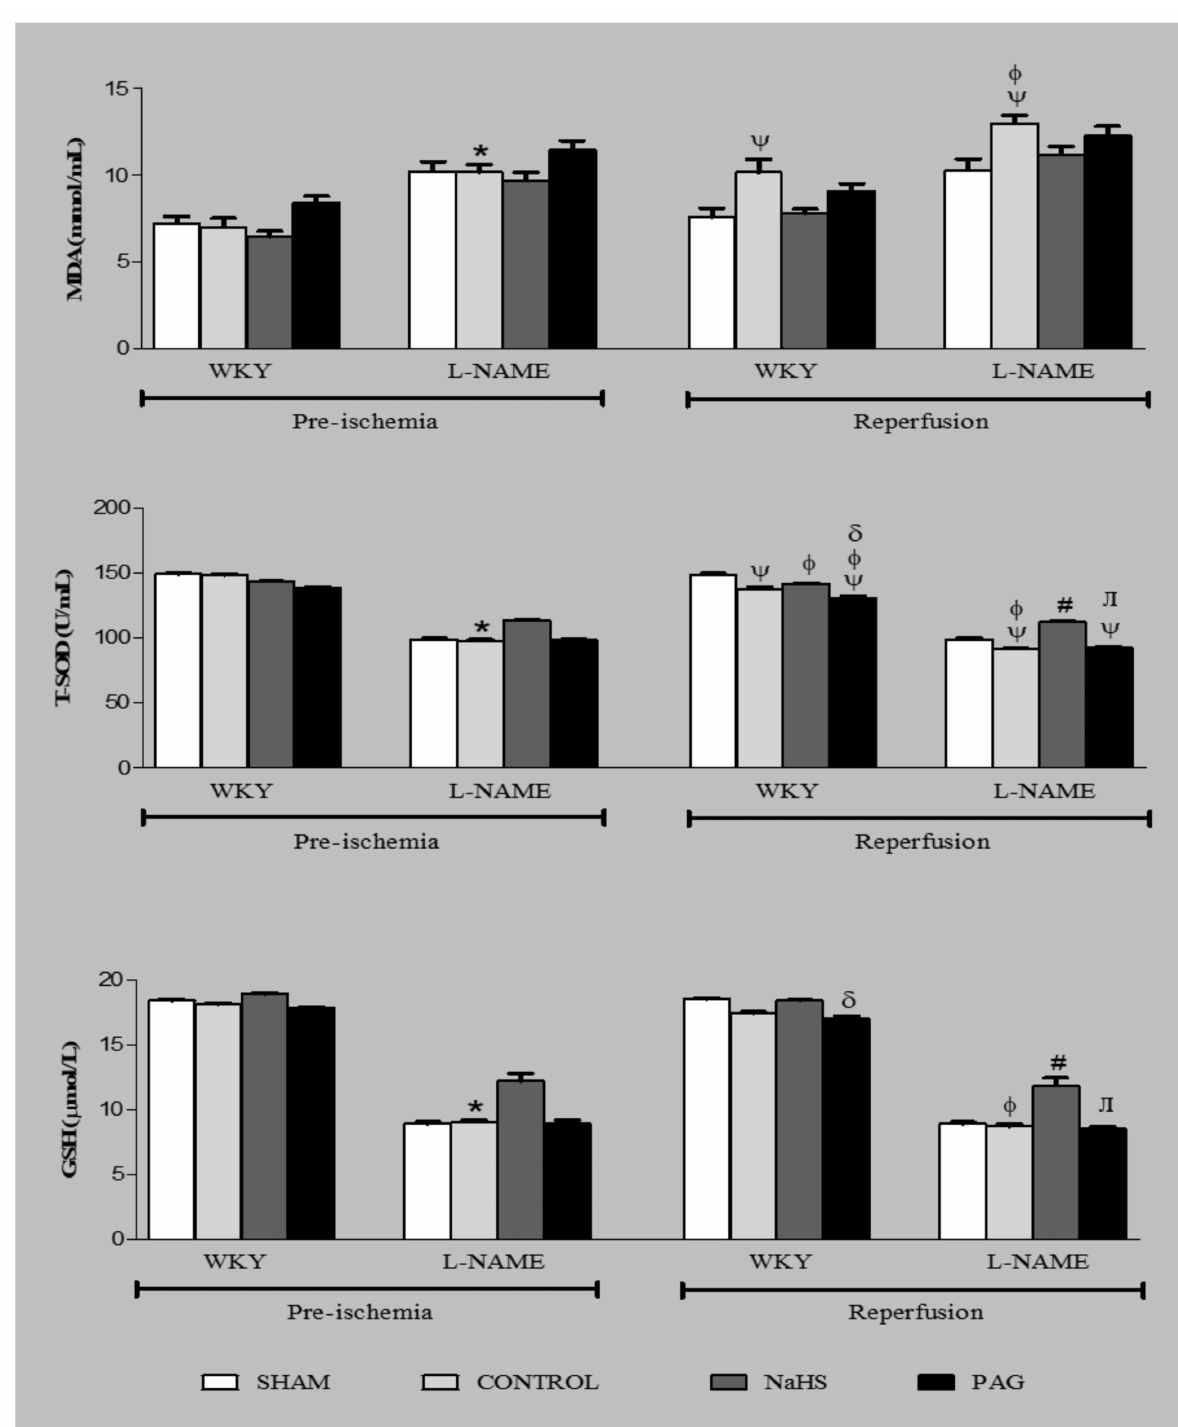
Figure 4. MDA, T-SOD and GSH concentrations in different experimental groups of WKY and L-NAME rats before and after ischemia ( n = 6). Data were analysed using one-way ANOVA followed by Bonferroni’s post hoc test. Ψ p < 0.05 vs. pre- ischemic phase of respective groups; * p < 0.05 vs. WKY-CONTROL at pre-ischemic phase; φ p < 0.05 vs. WKY-CONTROL at reperfusion phase; δ p < 0.05 vs. WKY+NaHS at reperfusion phase; # p < 0.05 vs. L-NAME-CONTROL at reperfusion phase; л p < 0.05 vs. L-NAME+NaHS at reperfusion phase. MDA = malondialdehyde, T-SOD = total superoxide dismutase, GSH = glutathione, PAG = dL-propargylglycine, WKY = Wistar Kyoto rats, L-NAME =